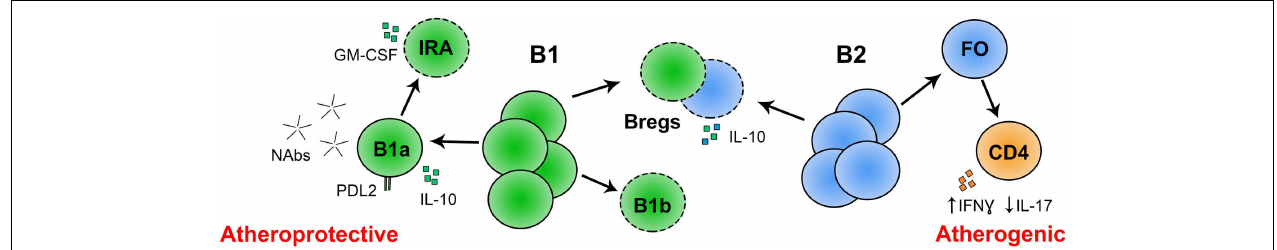
production of IgM, and potentially IL-10. PD-L2 is expressed on anti-PC B-1a B cells, potentially marking atheroprotective cells within this subset.The role of innate response activator B cells (IRA; derived from peritoneal B-1a B cells) in atherosclerosis is unknown but they produce GM-CSF, which may be linked to atherogenesis.The role of B-1b B cells in atherosclerosis is unknown. *(- - -) Role in atherosclerosis not yet reported.